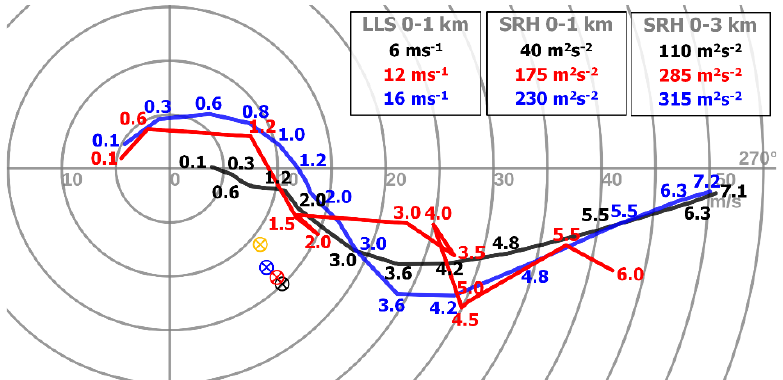
Figure 10. Hodographs representing the Michalovce area before tornadogenesis based on observations from weather stations, Gánovce sounding, and vertical-azimuth display (VAD) Kojšovská hoľa (red) simulation of 3 October 2018, 06:00 UTC NWP OPM run (black), and 3 October 2018, 06:00 UTC ELAM run (blue). Crossed circles: storm-motion vectors (SMVs); orange: real SMV derived from track of weak-echo region in radar data. Other SMVs computed by Bunkers method on basis of wind data in 0–4 km layer and for wind profiles from respective datasets. Values of observed simulated low-level wind shear (LLS) and storm relative helicity (SRH) in 0–1 and 0–3 km layers shown in top-right corner.